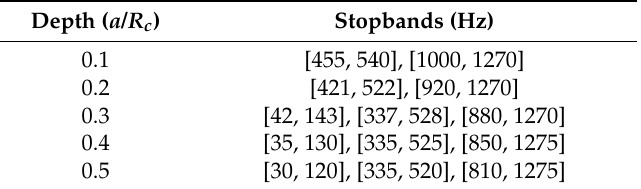
Table 6. Experimental stopbands derived at different crack depths.